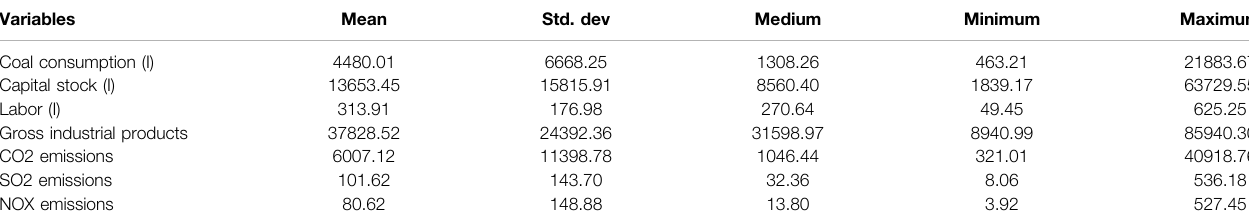
TABLE 1 | Descriptive statistics of input-output from 2010 to 2019. Variables Mean Std. dev